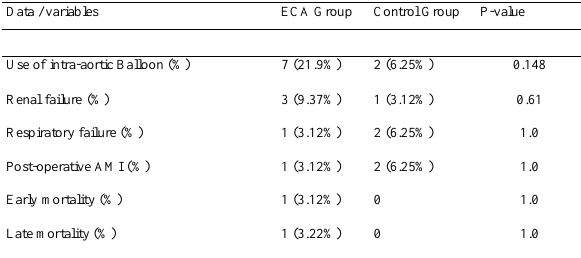
m = mean; AMI = acute myocardial infarction.